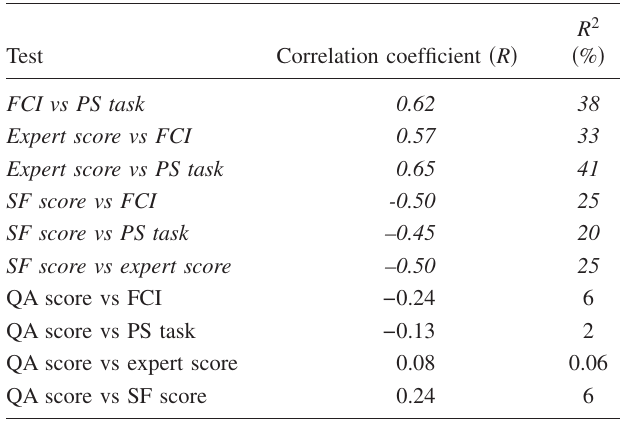
TABLE III. Summary of correlation coefficient and R 2 values between all post-tests. Items that are statistically significant are